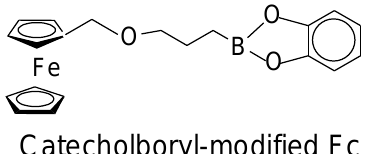
Figure 9. Chemical structure of catecholboryl-modified